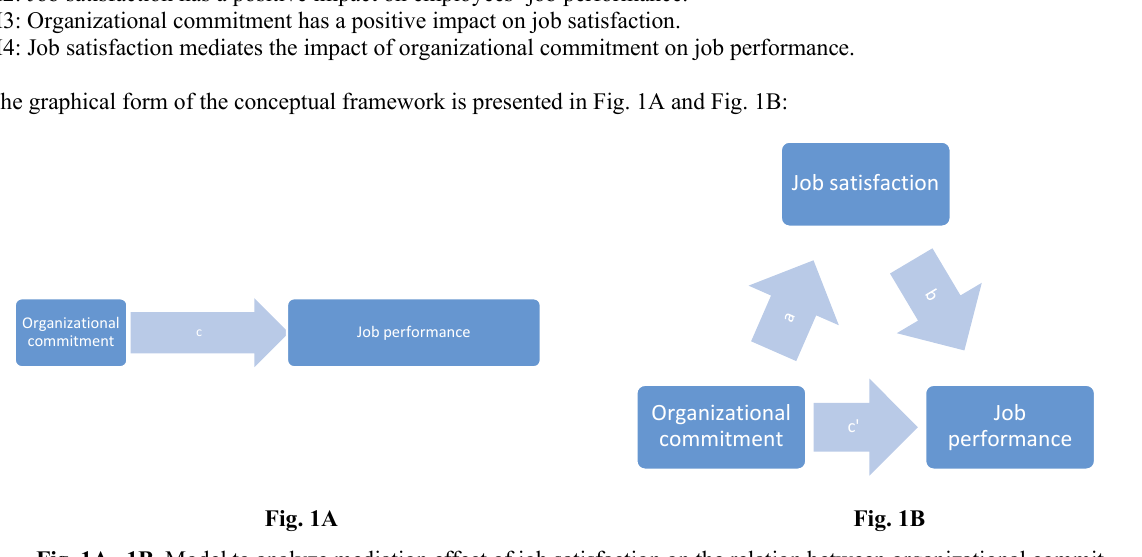
Fig. 1A., 1B. Model to analyze mediation effect of job satisfaction on the relation between organizational commit- ment and job